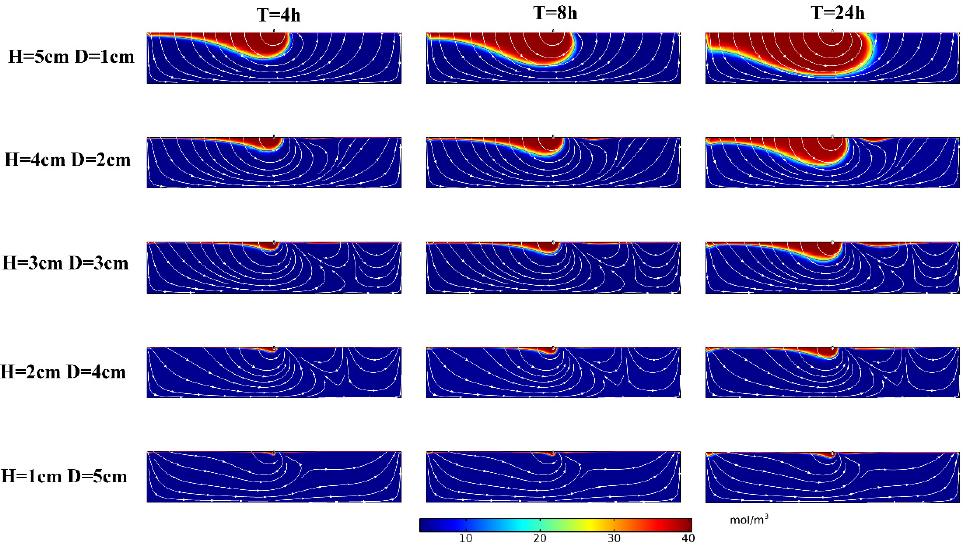
Figure 4. Solute transport in the hyporheic zone under the influence of structural H and D changes. The color scale for the outputs, representing solute concentration; warmer colors: higher concentra- tion, cooler colors: lower concentration. Flow in the overlying water column (not shown) is from left to right. T represents time.